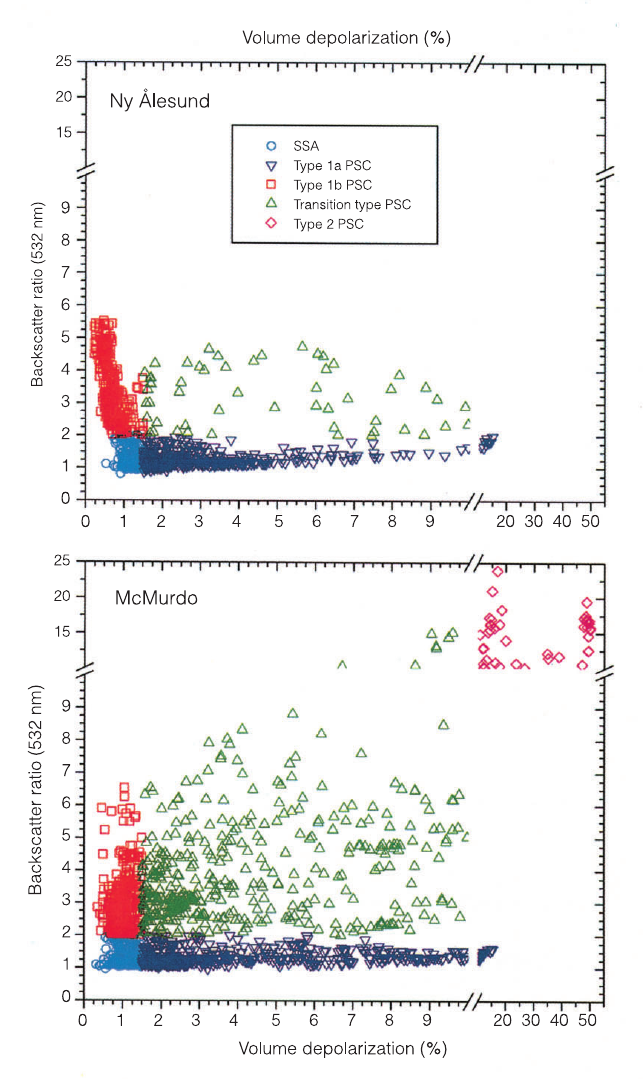
Fig. 3. Scatter plot of 532 nm backscatter ratio versus volume depolarisation from lidar measurements at Ny Ålesund, Spitsbergen (upper panel) and Antarctic measurements at McMurdo (lower panel), illustrating the grouping of different particle types observed in the polar winter stratosphere (adapted from World Meteorological Organization, 1999, courtesy R. Neuber and A.